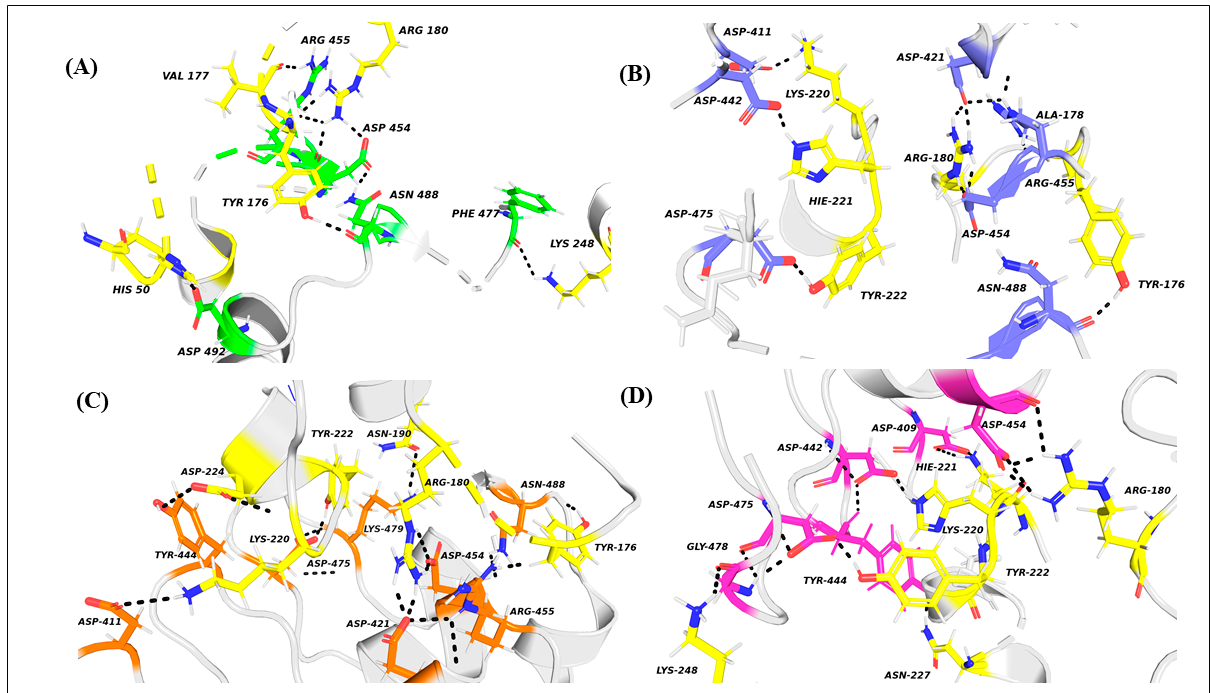
Figure 6. Polar contacts of the complexes of ERK2; residues shown in yellow with ( A ) E40 in green, ( B ) S380L in blue, ( C ) A443D in orange, and ( D ) D421W in pink. Polar interactions are shown by black dotted lines.